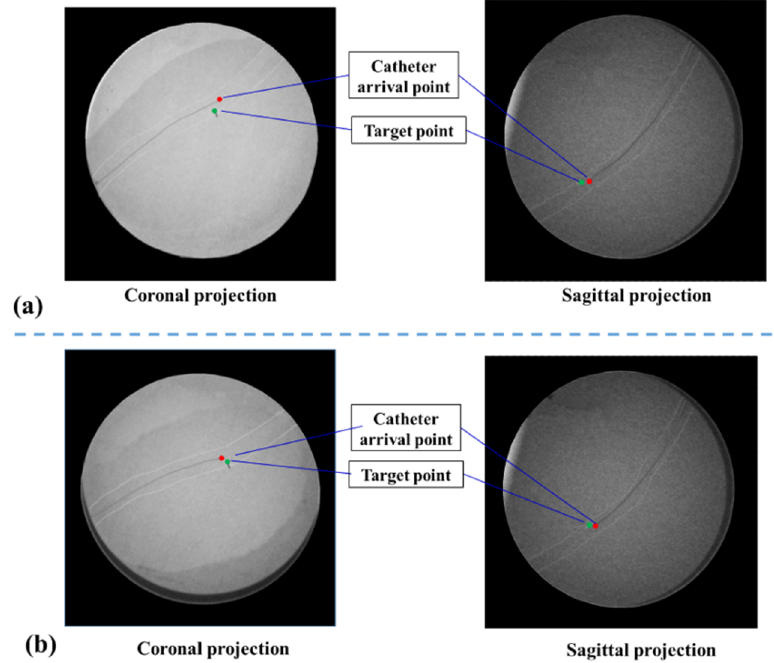
Figure 11. ( a ) Two perpendicular X ‐ ray projections were taken to verify the targeting distance between the catheter arrival position and target point during catheter intervention under the global guidance alone; ( b ) Two perpendicular X ‐ ray projections under the global map plus local navigation.